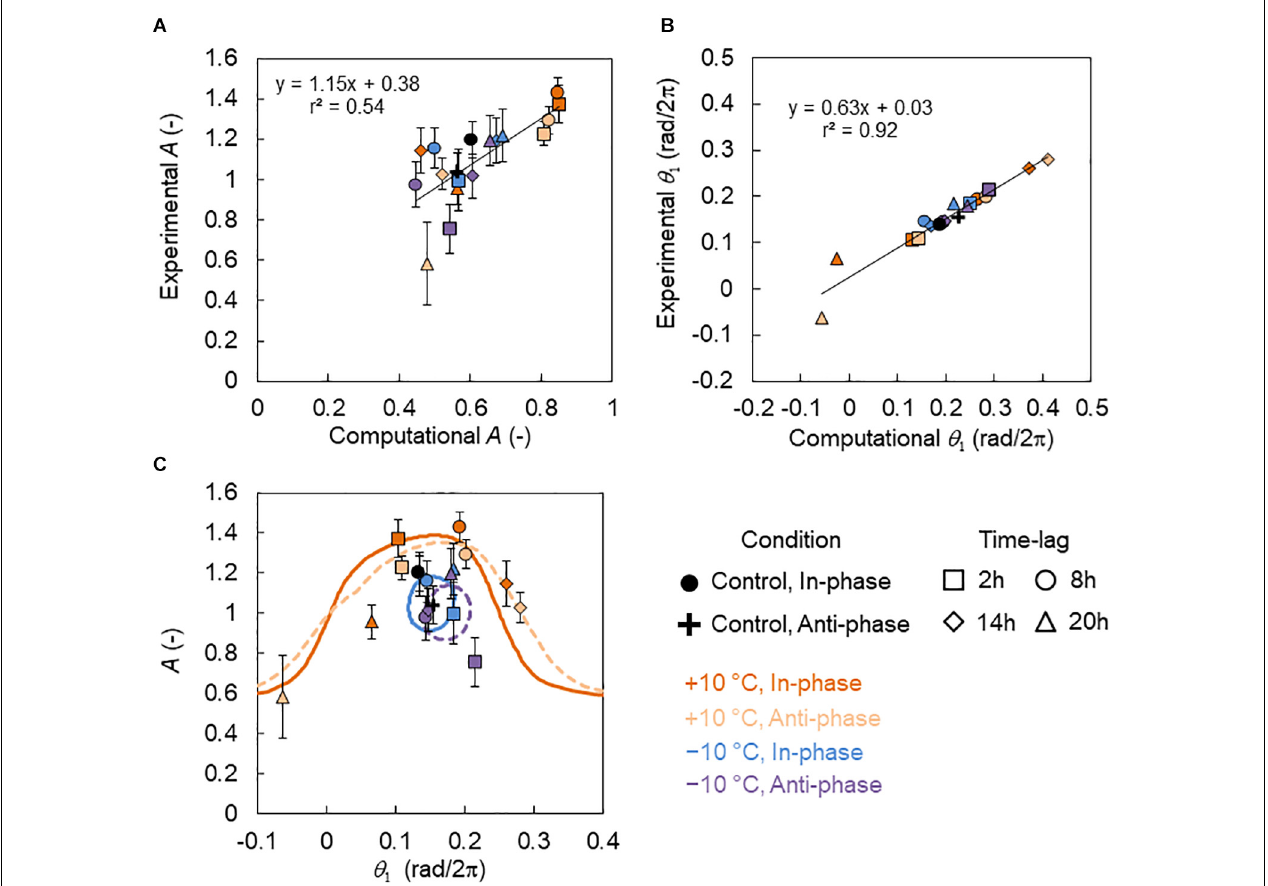
FIGURE 3 | Relationship between the amplitude and locking phase of the CCA1 rhythms in the experiments and simulations. (A) Correlation between amplitudes A in the experiment and simulation (mean ± SD in experiment). (B) Correlation between the locking phase θ 1 in the experiment and the simulation (circular mean in experiment). The black lines indicate regression lines. (C) Relationship between A (mean ± SD) and θ 1 (circular mean). The symbols indicate the experimental data points. The colored lines indicate the relationship between A and θ 1 in the simulation. The solid lines indicate the in-phase conditions and the broken lines indicate the antiphase conditions. The simulation values of A and θ 1 were calibrated using the regression lines in (A) and (B) as A calibrated = 1.15 A + 0.38 and θ 1 , calibrated = 0.63 θ 1 +